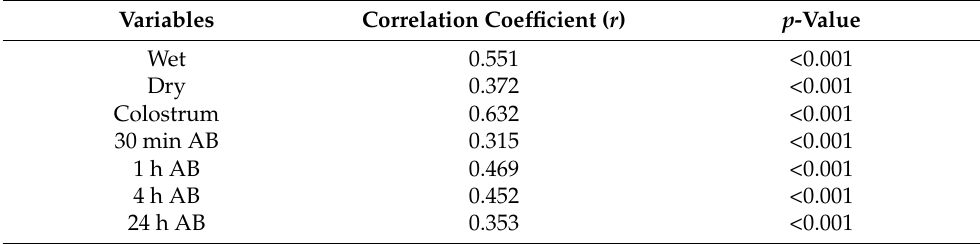
Table 11. Significant correlations between puppies’ weight and their superficial temperature at TLM thermal window.